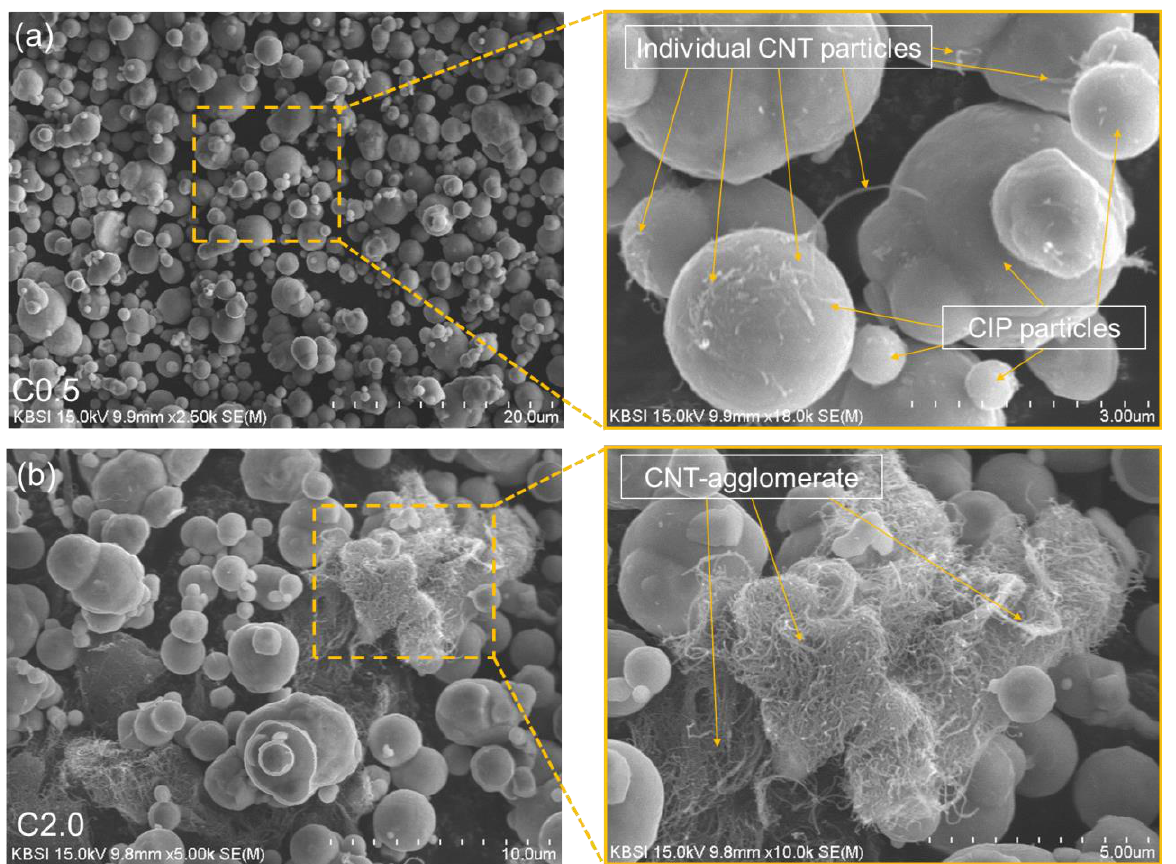
Figure 2. SEM images of CNT and CIP-based conductive networks in the samples with ( a ) CNT 0.5% and ( b ) CNT 2.0%. Table 2. Zeta potential test results of the CNTs and CIP in IPA solvent. Zeta Potential (mV) IPA Solvent CNTs in IPA CIP in IPA CNTs and CIP in IPA